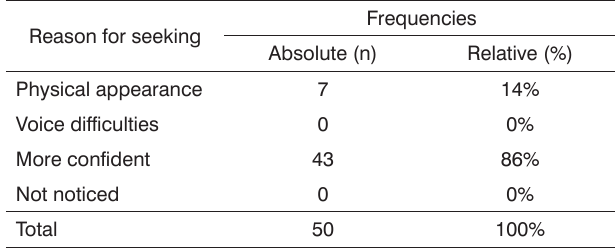
Reason for seeking